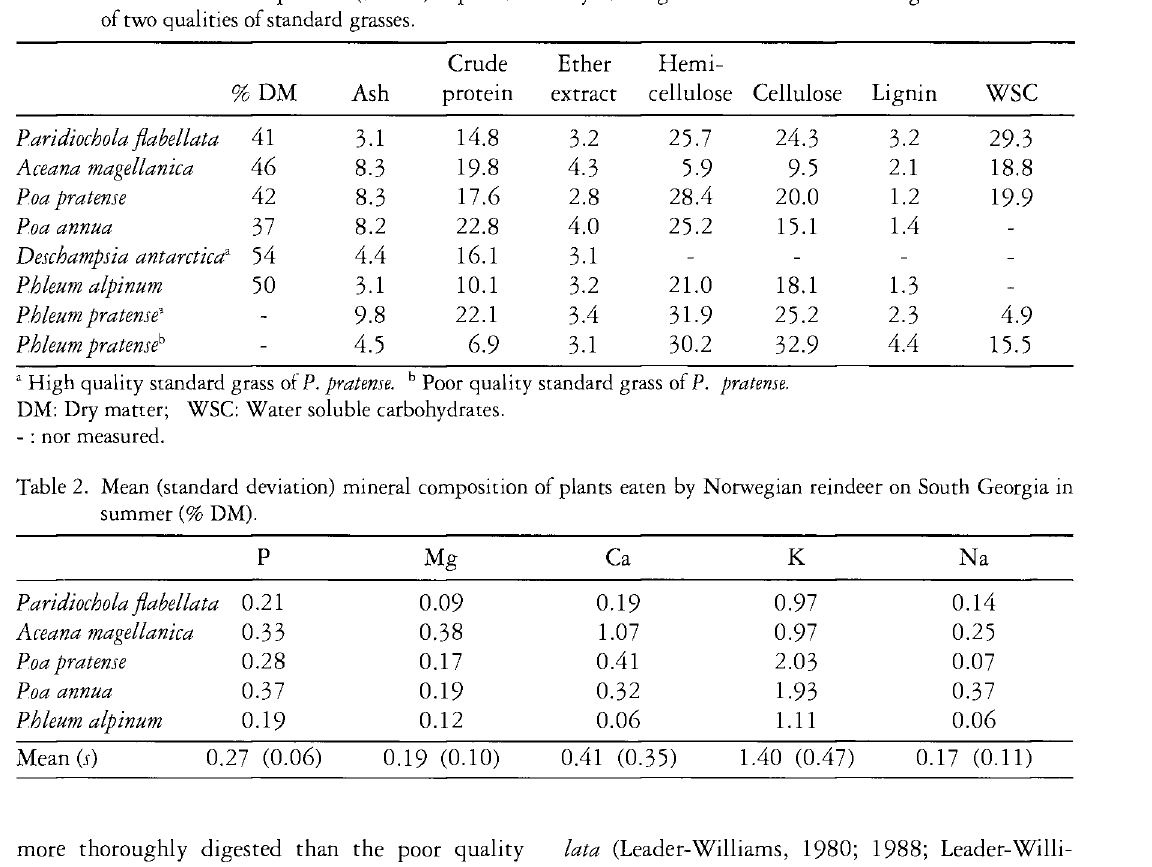
Table 1. Mean chemical composition (% DM) of plants eaten by Norwegian reindeer on South Georgia in summer and of two qualities of standard grasses. Crude Ether Hemi- % DM Ash protein extract cellulose Cellulose Lig ;nin WSC Paridiochola flabellata 41